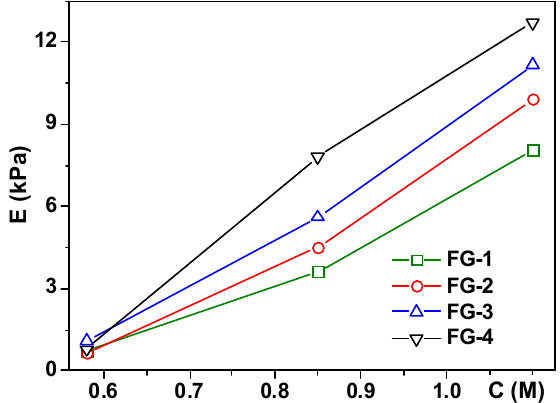
Figure 7. Young modulus of ferrogels with different concentration of acrylamide (C) taken in the synthesis of gel matrix for different FG series: FG-1 filled with magnetite if the thickener was guar gum and FG-2 if the thickener was xanthan gum, filled with strontium hexaferrite FG-3 (thickener–guar gum) and FG-4 (thickener–xanthan gum). Weight fraction ranges of magnetic particles were 2.59–5.20 wt % for FG-1, 0.77–3.19 wt % for FG-2, 1.31–3.70 wt % for FG-3 and 0.77–3.33 wt % for FG-4. Lines are for eye-guide only. C-concentrations were as high as 1.1 M, 0.85 M and 0.58 M aiming to provide gels with varying elasticity.